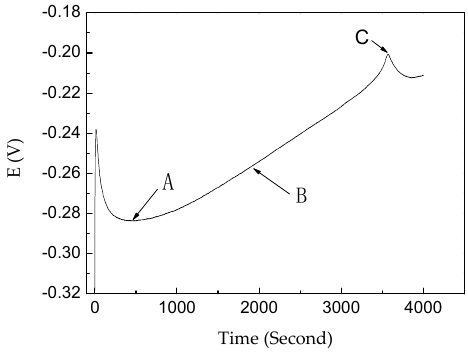
Figure 2. Potential-time curve of stainless steel in coloring process.